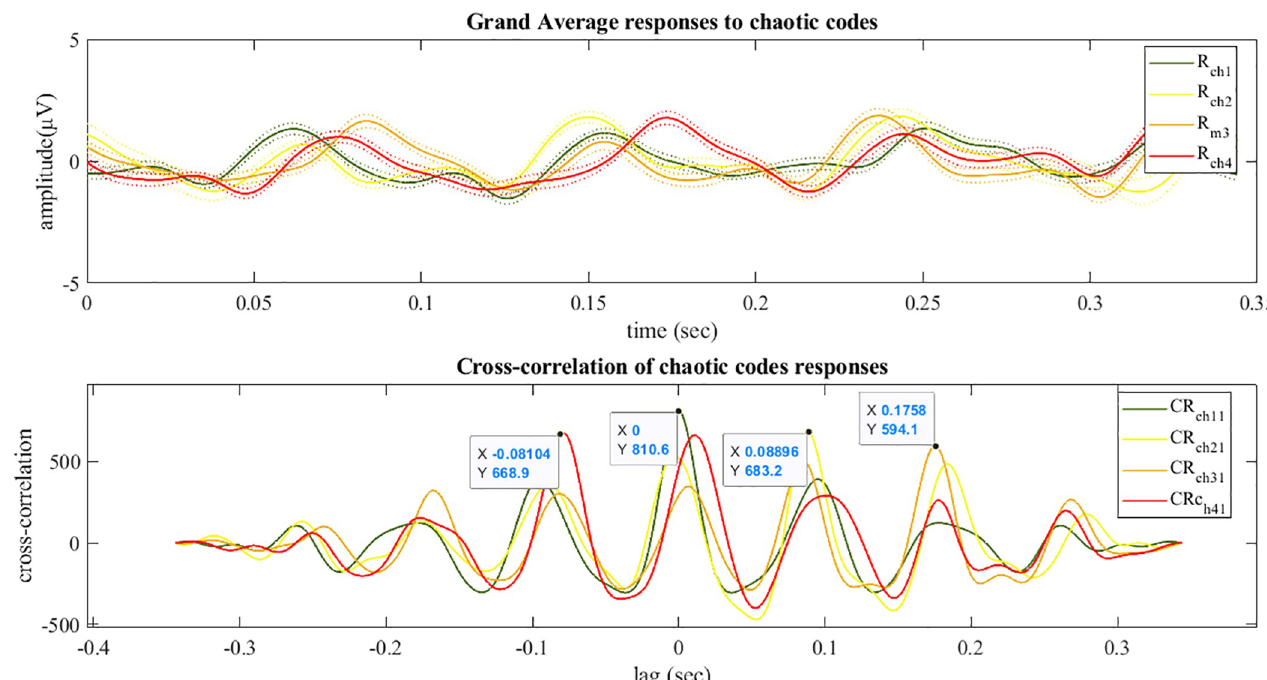
Fig 13. Grand average and cross-correlations of evoked responses to chaotic codes. The grand average of responses to codes Ch i ( i = 1:4) is shown with waveforms of R their corresponding standard errors are shown with dotted plots (top) and the auto-correlation of response R ch i the responses R ð i ¼ 2 : 4 Þ is shown with the waveforms of CR ch i values (as shown) where they were